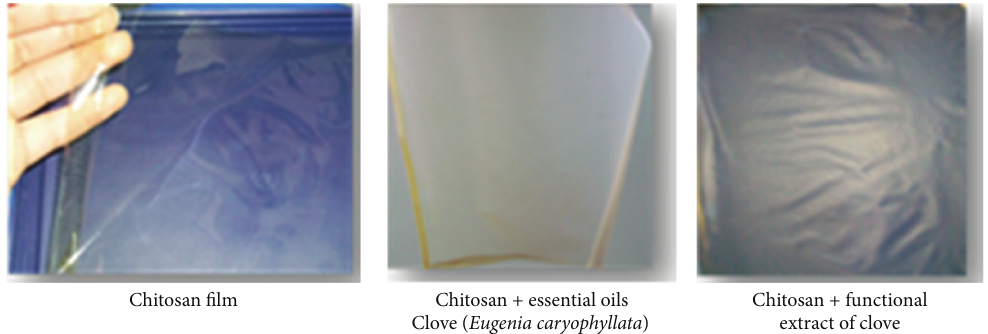
Figure 1: A typical image of a chitosan-based films including spices of essential oils and functional extract of clove.